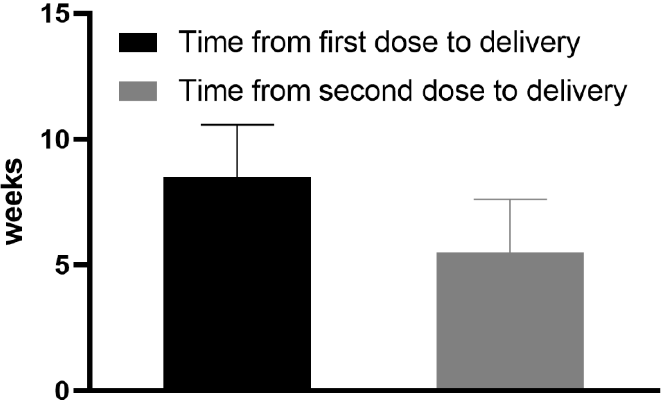
Figure 1. Mean time (weeks) from the first and the second dose of vaccine to delivery. Table 1. Maternal and newborn demographic and clinical data. Variable